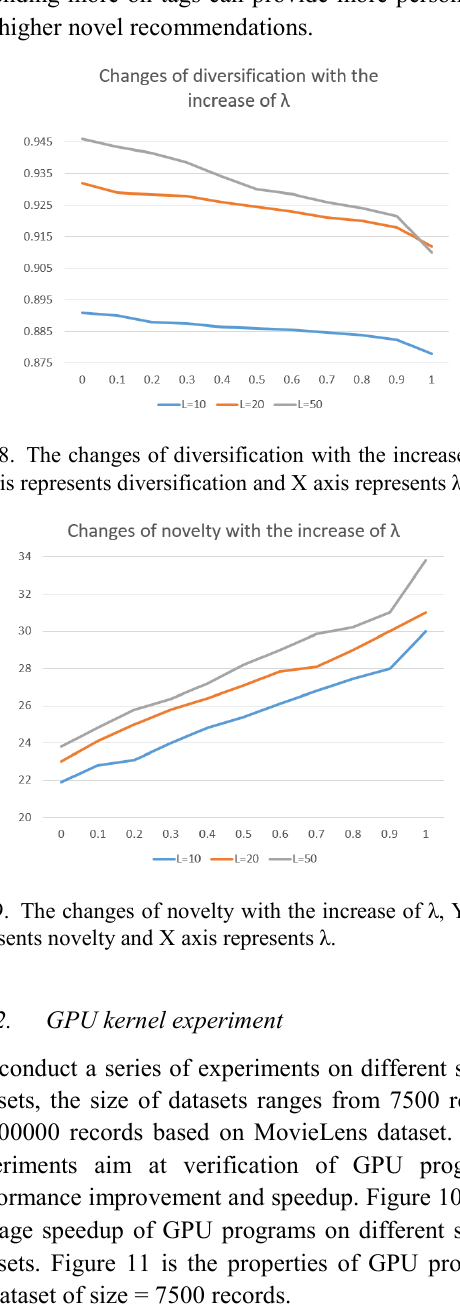
Fig. 11. The properties of GPU kernel on dataset of size = 7500